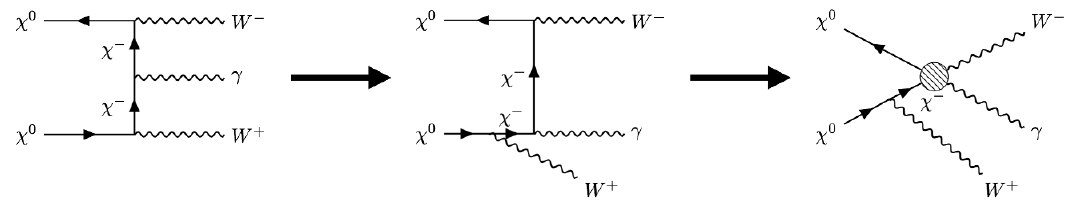
Figure 13 . A visualization of one example for how the internal bremsstrahlung diagram is captured within the EFT framework. Once the diagram on the left has been rearranged as it appears in the center, and taking the soft kinematics for the W + , this process amounts to a 2 accompanied by an additional W emission as shown on the